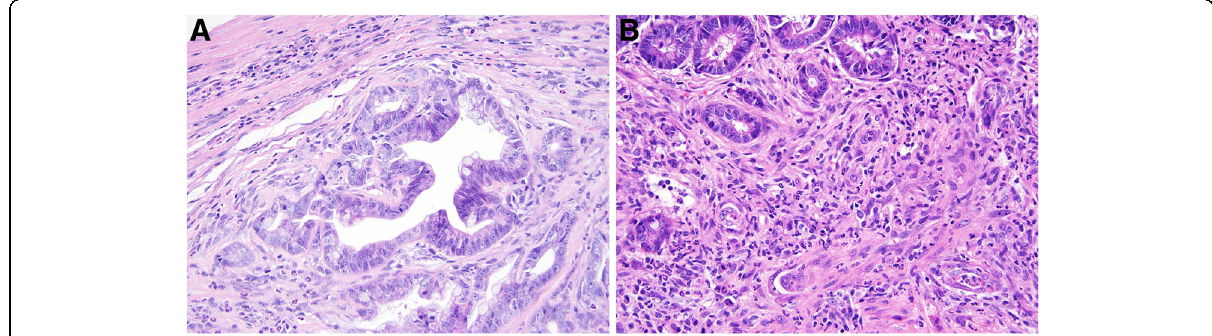
Fig. 9 a Invasive carcinoma may be seen in longer-lived Apc Min/+ -related models. In contrast to the smooth crypt profile of herniation, the invasive adenocarcinoma shown here has an angulated profile with infiltration of tumor cells into a desmoplastic stroma. b In this example from a Apc 1638N/+ mouse, adenocarcinoma cells infiltrate the lamina propria as small angulated glands with pointed profiles and elicit an inflammatory and stromal